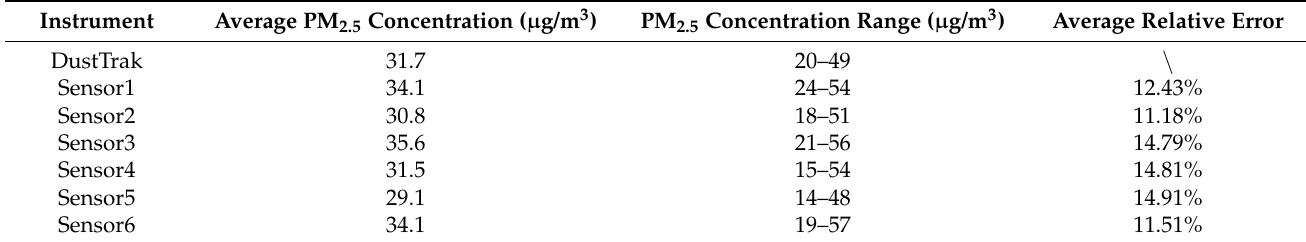
Table 1. Comparison of the test performance of different